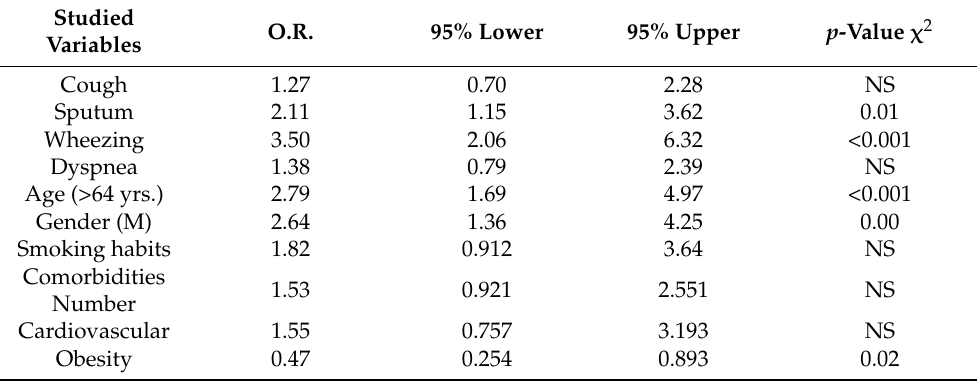
Table 7. Logistic multivariate model to evaluate the effect of studied variables on